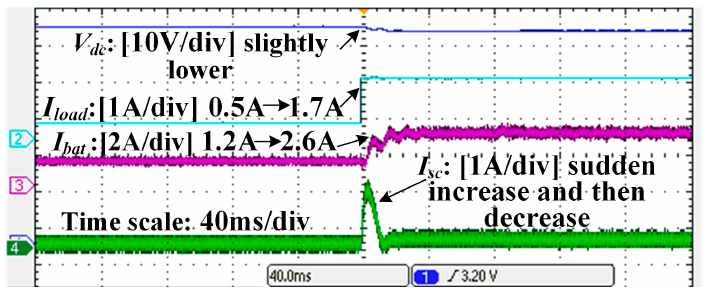
Figure 19. Control parameters of Group G: DC bus voltage, CPL current, battery current and SC current of a DC microgrid.